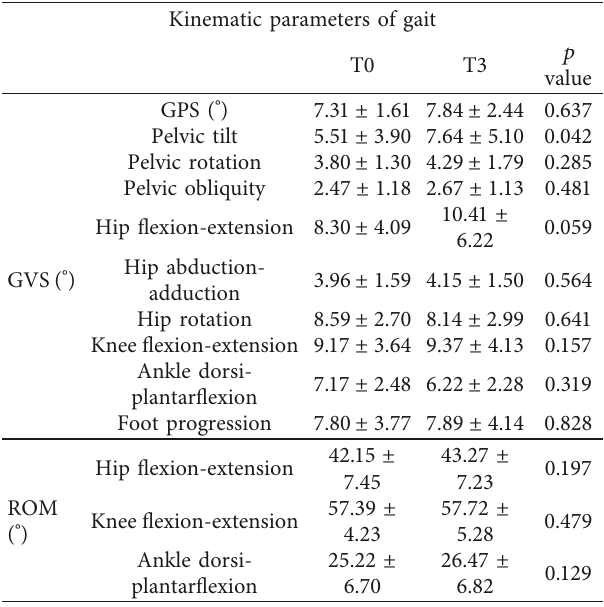
Table 4: Values of the kinematic parameters of gait at the be- ginning and end of the 3-month observation